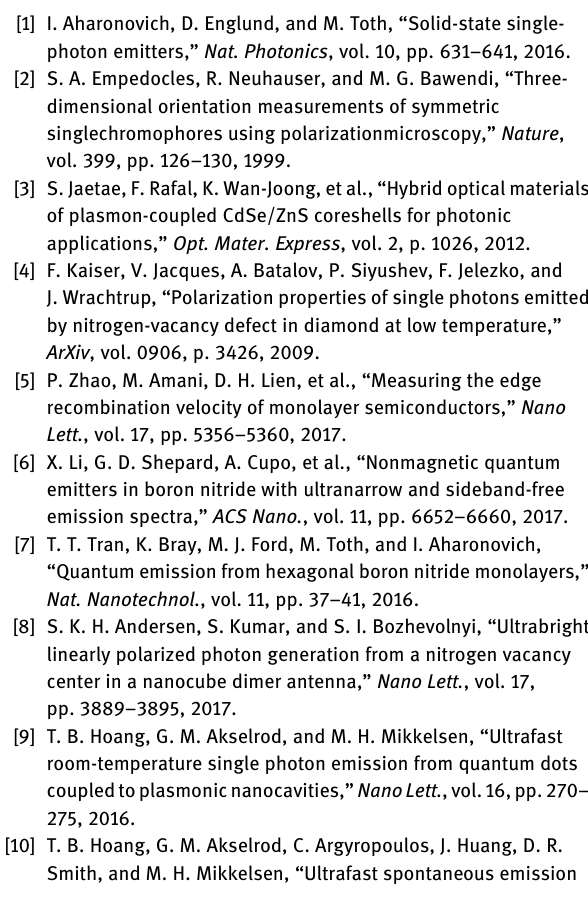
Figure 1b. The emission wavelength of the dipole is set to λ = 650 nm. The position of the dipole is (0,0, [1 + sin(72 ° )] em R + d